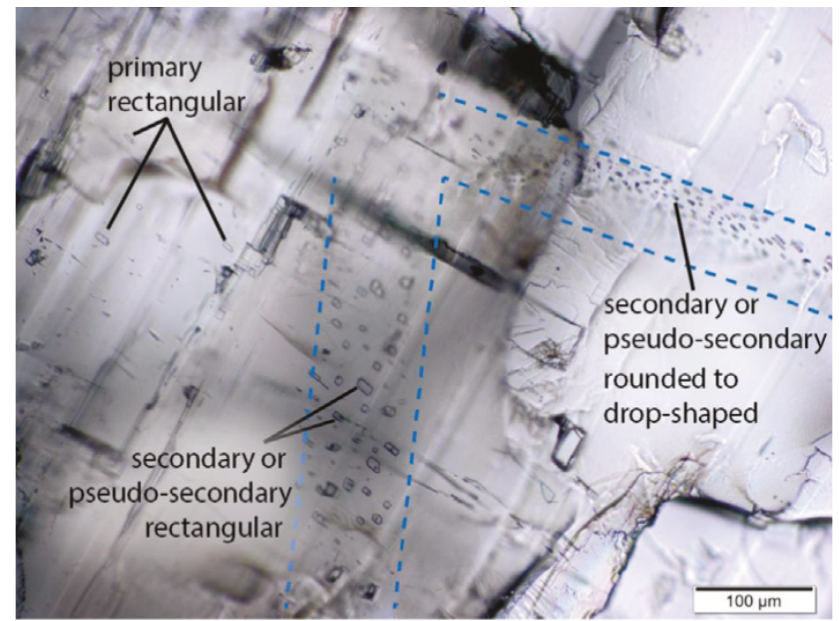
Figure 6: Fluid inclusion morphology in vein calcite crystals in one focal